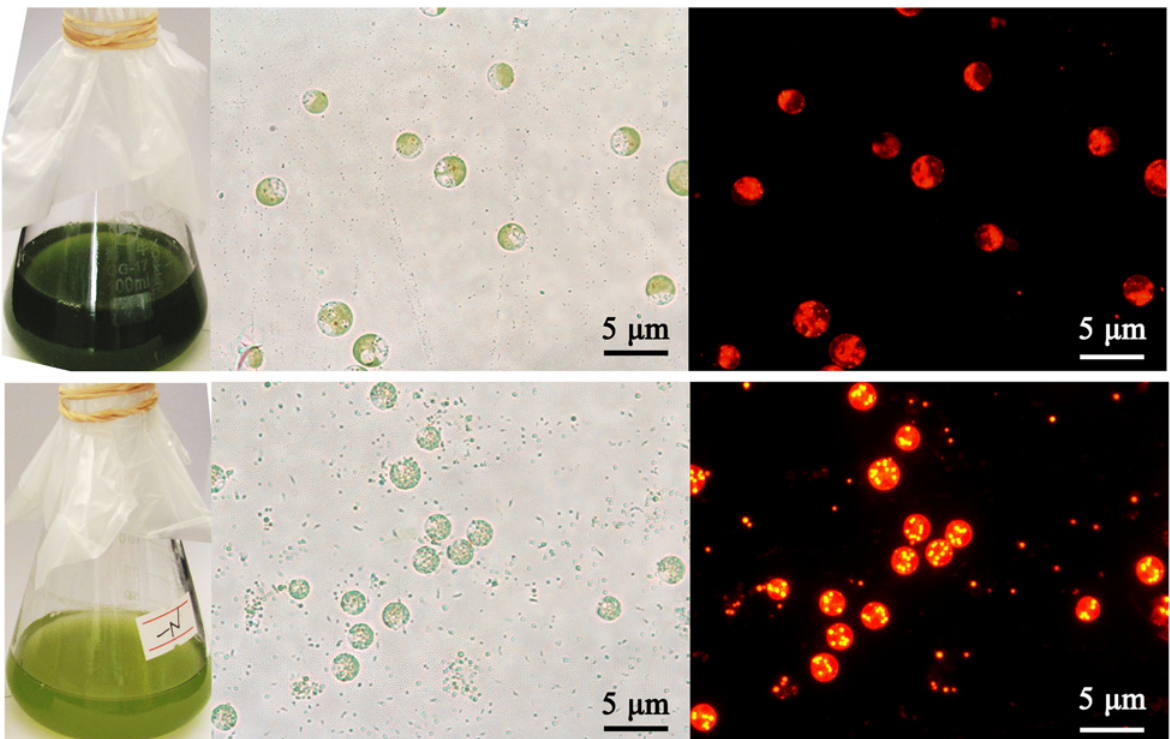
Fig 5. Effect of nitrogen starvation on lipid accumulation in C . reinhardtii . Microalgae cells were cultured in HSM and HSM-N for 4 days. The cell culture medium turned yellow when grown under N starvation. The nonpolar lipid in cells was stained using Nile red and imaged using a Nikon 80i fluorescence microscope. The lipid drops are shown as yellow dots under dark field. Red indicates chlorophyll autofluorescence. The upper panel shows cells grown in HSM, and the lower panel shows cells grown in HSM-N. From left to right: cell culture fluids, bright field images and fluorescent images. Scale bar = 5 μ m.